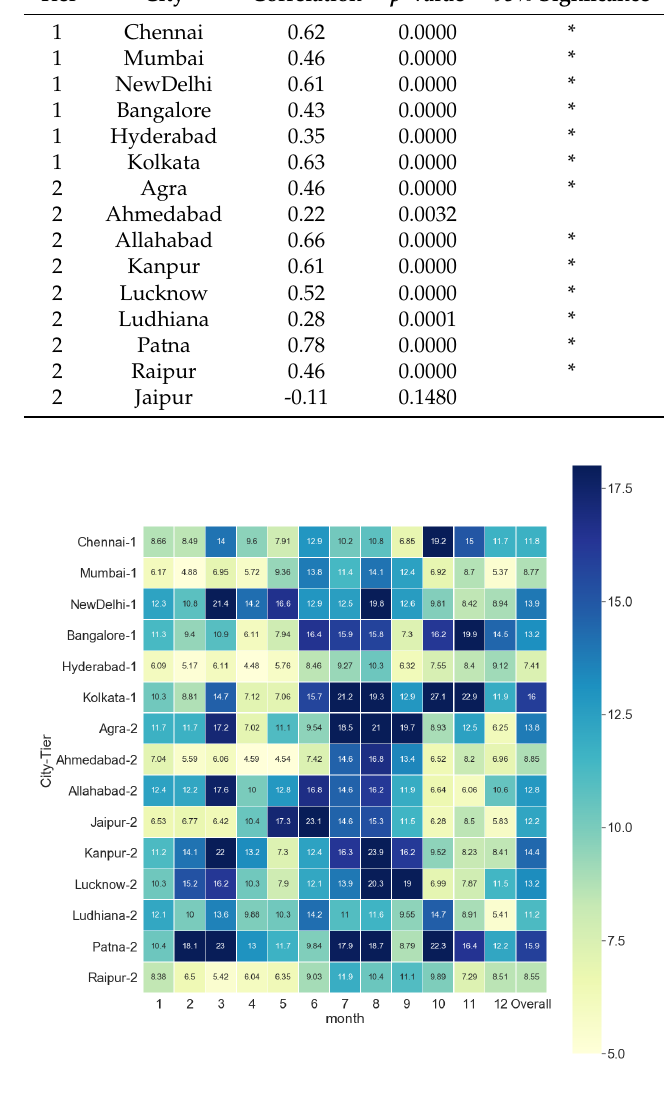
Figure 8. Monthly and overall root mean square error (RMSE) between the observed R obs and estimated R est for each